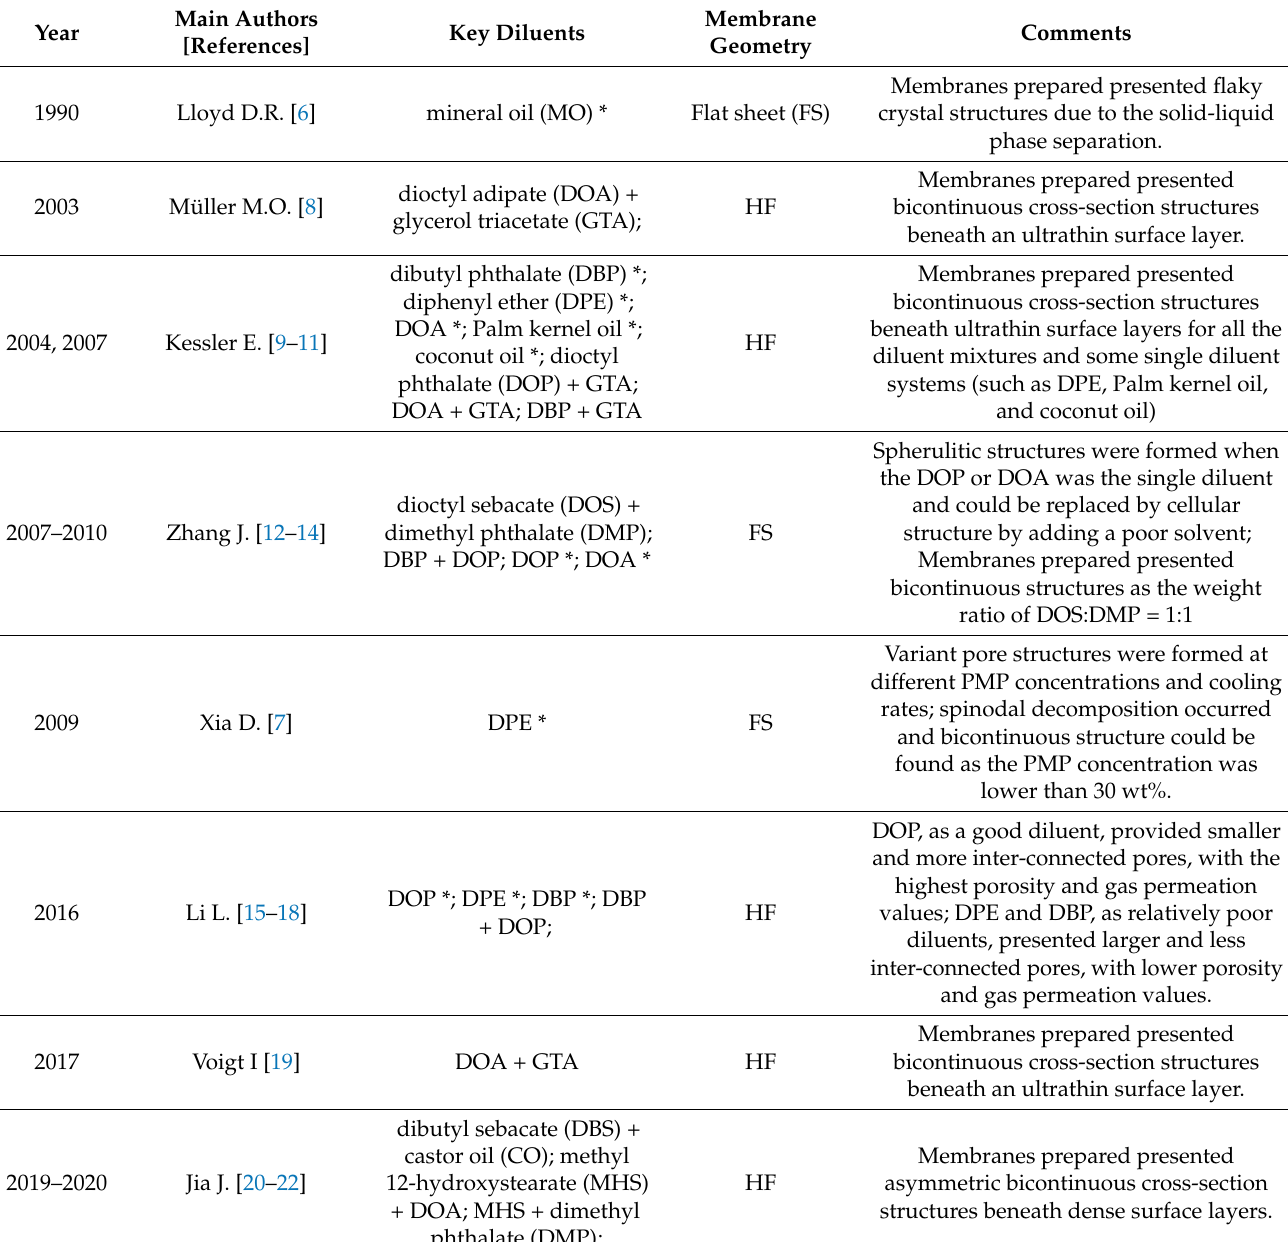
Table 1. A summary of the key results of the previous research works related to the PMP membrane preparation via TIPS from 1990 to